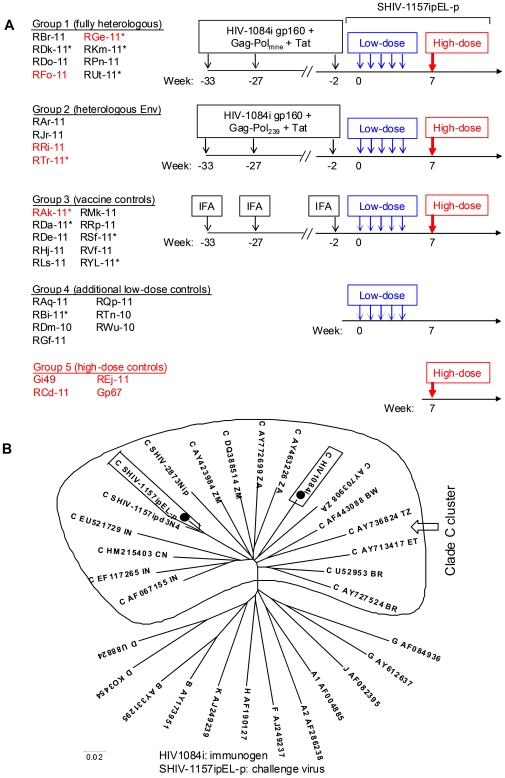
Experimental time line and phylogenetic analysis of Env of immunogen and challenge virus.(A) Experimental design. Groups 1 and 2 were vaccinated with HIV-1 Tat, HIV1084i gp160, and Gag-Pol particles from either SIVmne (Group 1) or SIVmac239 (Group 2; 100 µg of each immunogen i.m. in incomplete Freund's adjuvant (IFA)); Group 3 controls received IFA alone. Maximally 5 weekly low-dose i.r. challenges of SHIV-1157ipEL-p were given (8,000 50% tissue culture infectious doses (TCID50, measured by TZM-bl assay). SHIV-1157ipEL-p is heterologous to HIV1084i Env and SIVmne Gag-Pol immunogens. Group 4, unvaccinated rhesus monkeys (RM) challenged identically with the same virus stock as part of other studies. All RM with no viremia at week 7 (shown in red) were rechallenged i.r. with a single high-dose of SHIV-1157ipEL-p (1.5×105 TCID50; red arrows). Group 5: naïve controls for the high-dose challenge. *, Mamu A*001-positive RM. (B) Phylogenetic analysis of Env sequences of immunogen and challenge virus. HIV-1 Env sequences of clade C and non-clade C reference strains were obtained from the Los Alamos HIV-1 sequence database. The evolutionary tree was inferred using the Neighbor-Joining method [47] by MEGA4 software [48]. The immunogen and challenge virus sequences were on different branches within cluster of HIV-C Env sequences.